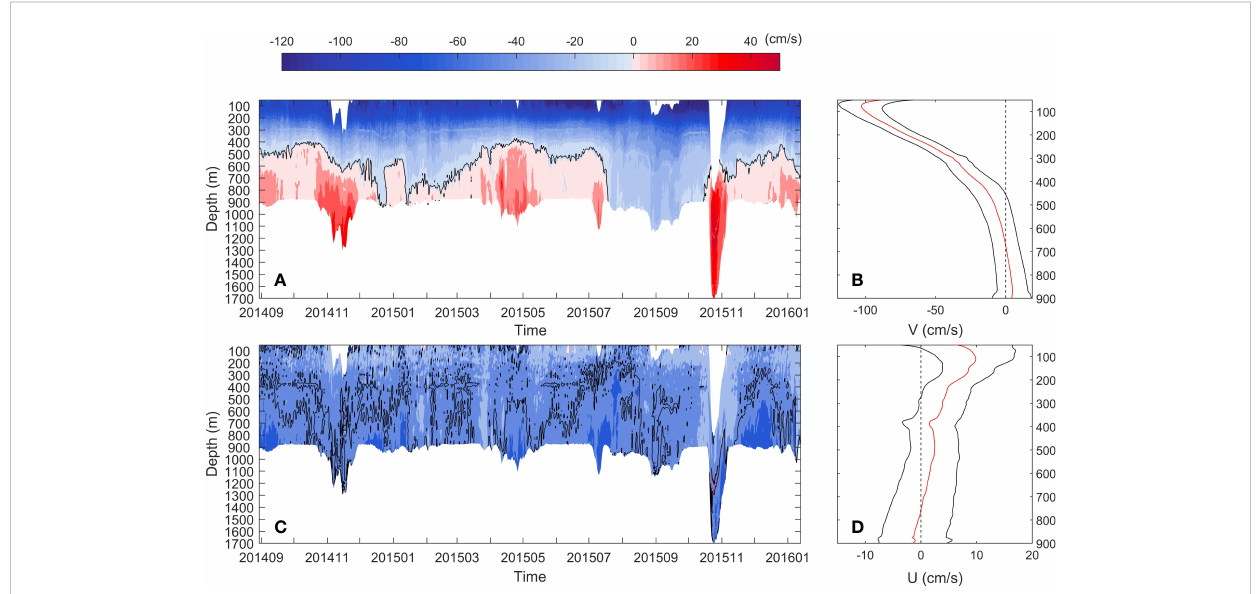
FIGURE 2 Time series of daily averaged velocity (cm s -1 ) measured by ADCPs at 8°N, 127°E from September 2014 to January 2016, with annual mean velocity (red line), standard deviation (black line) in meridional (A, B) and zonal (C, D) currents (cm s -1